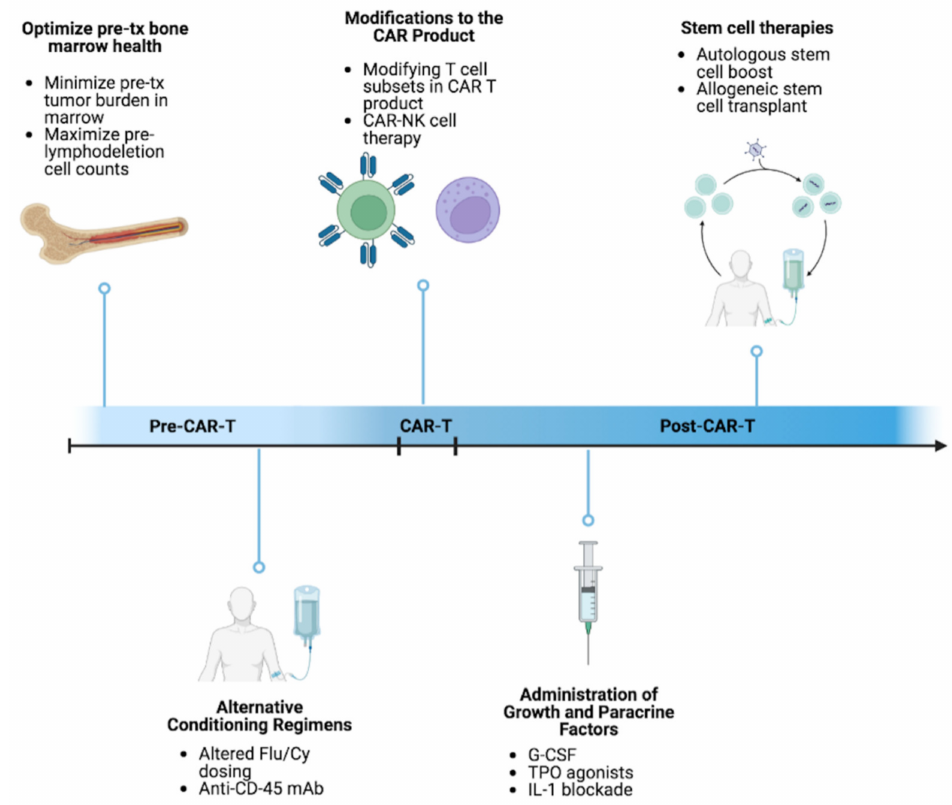
Figure 1. Strategies for improving hematopoiesis in the CAR T-cell setting to augment therapeutic